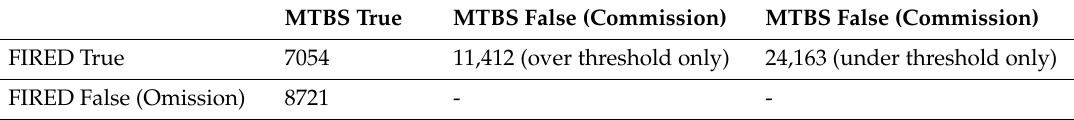
Table 5. Confusion matrix for comparison between FIRED events and MTBS events, where both products were above the MTBS-determined size threshold of 404 ha in the western US and 202 ha in the eastern US. The last column provides the number of small events that were delineated by FIRED below these size